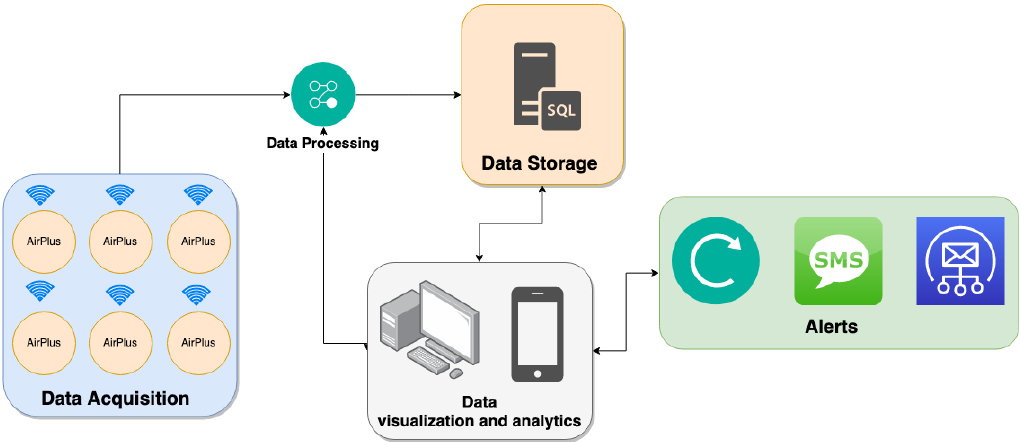
Figure 11. AirPlus notification architecture.